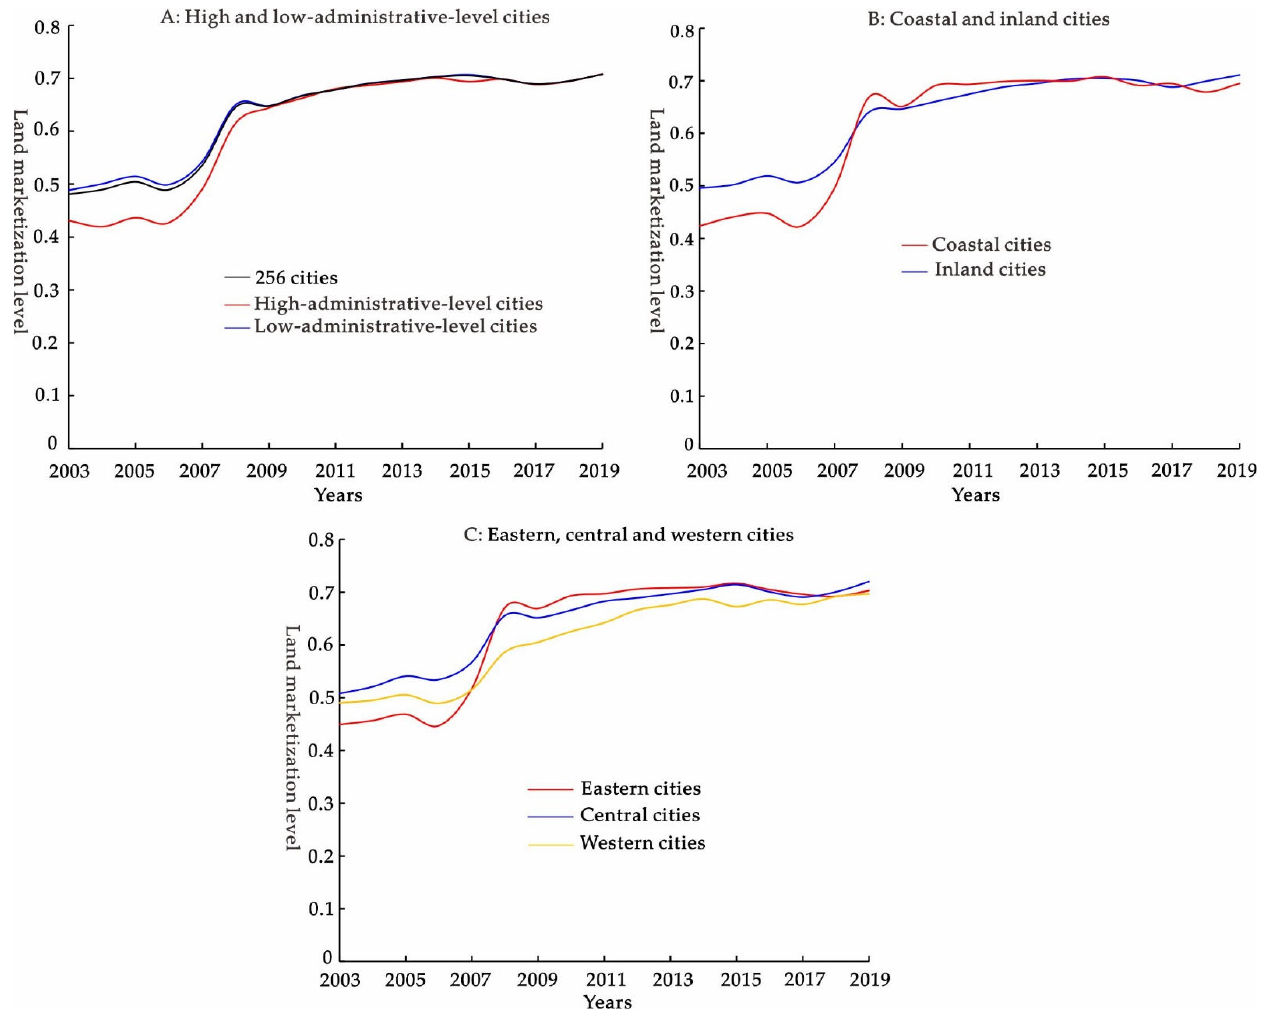
Figure 2. Land marketization level changes from 2003 to 2019.